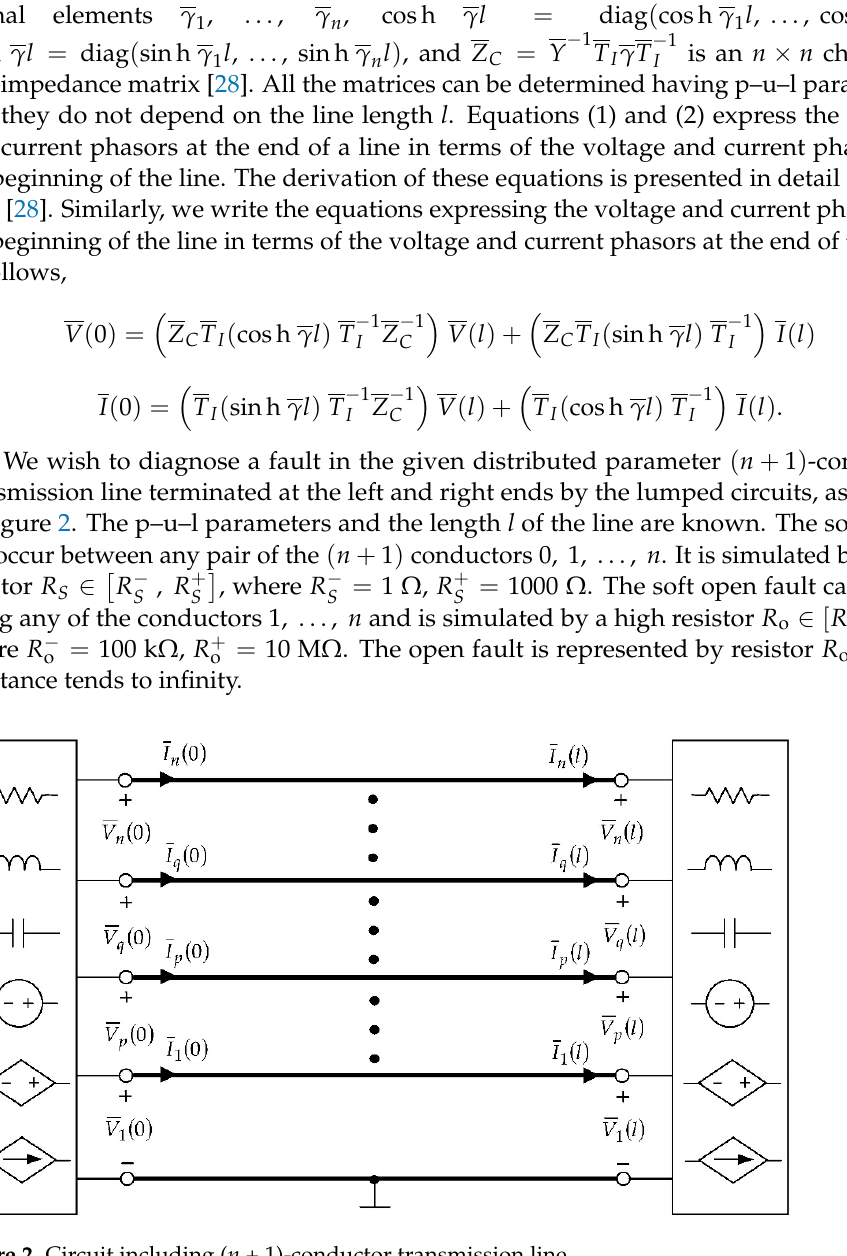
Figure 2. Circuit including ( n + 1)-conductor transmission